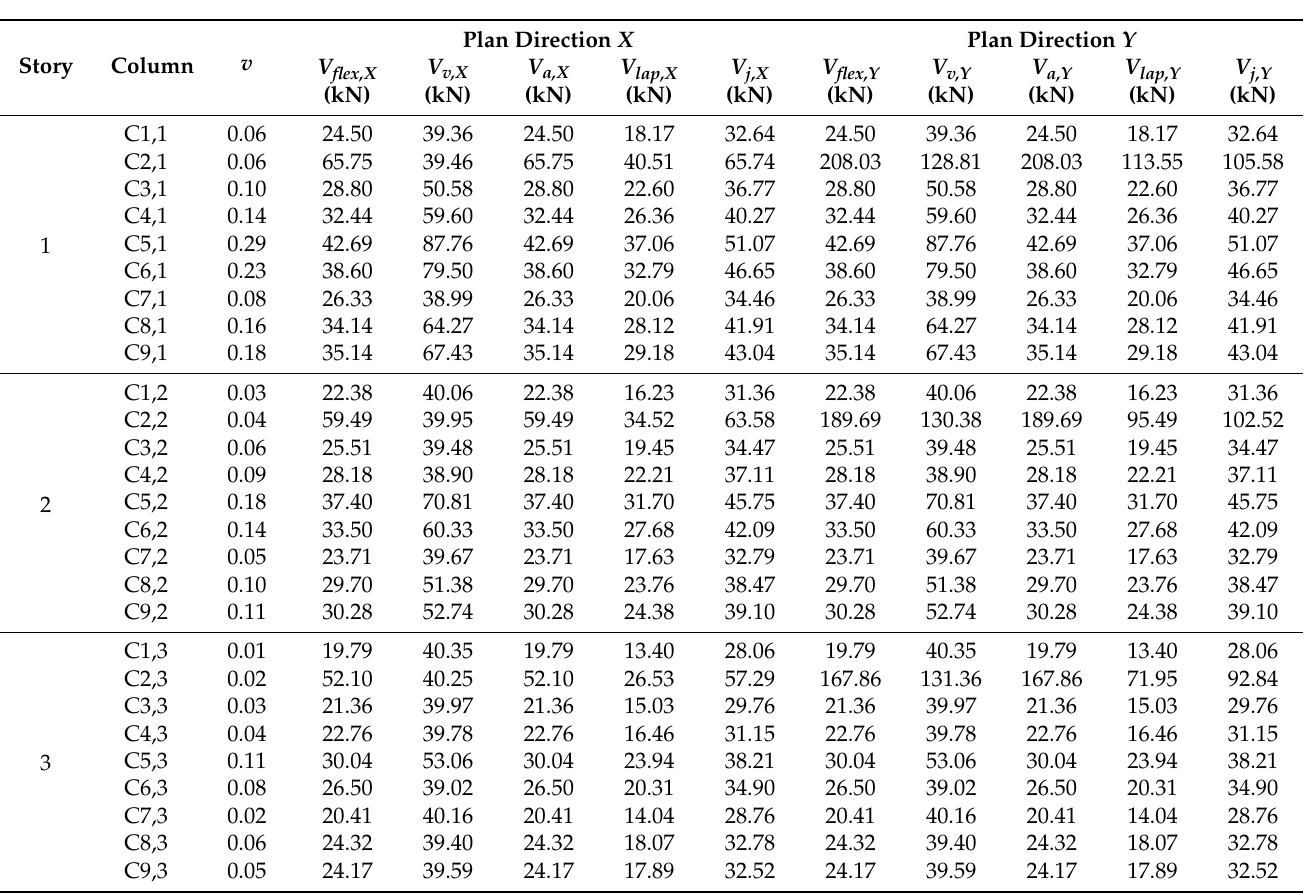
Table 1. Normalized average axial load and shear strengths of the SPEAR building columns calculated according to the RSA system